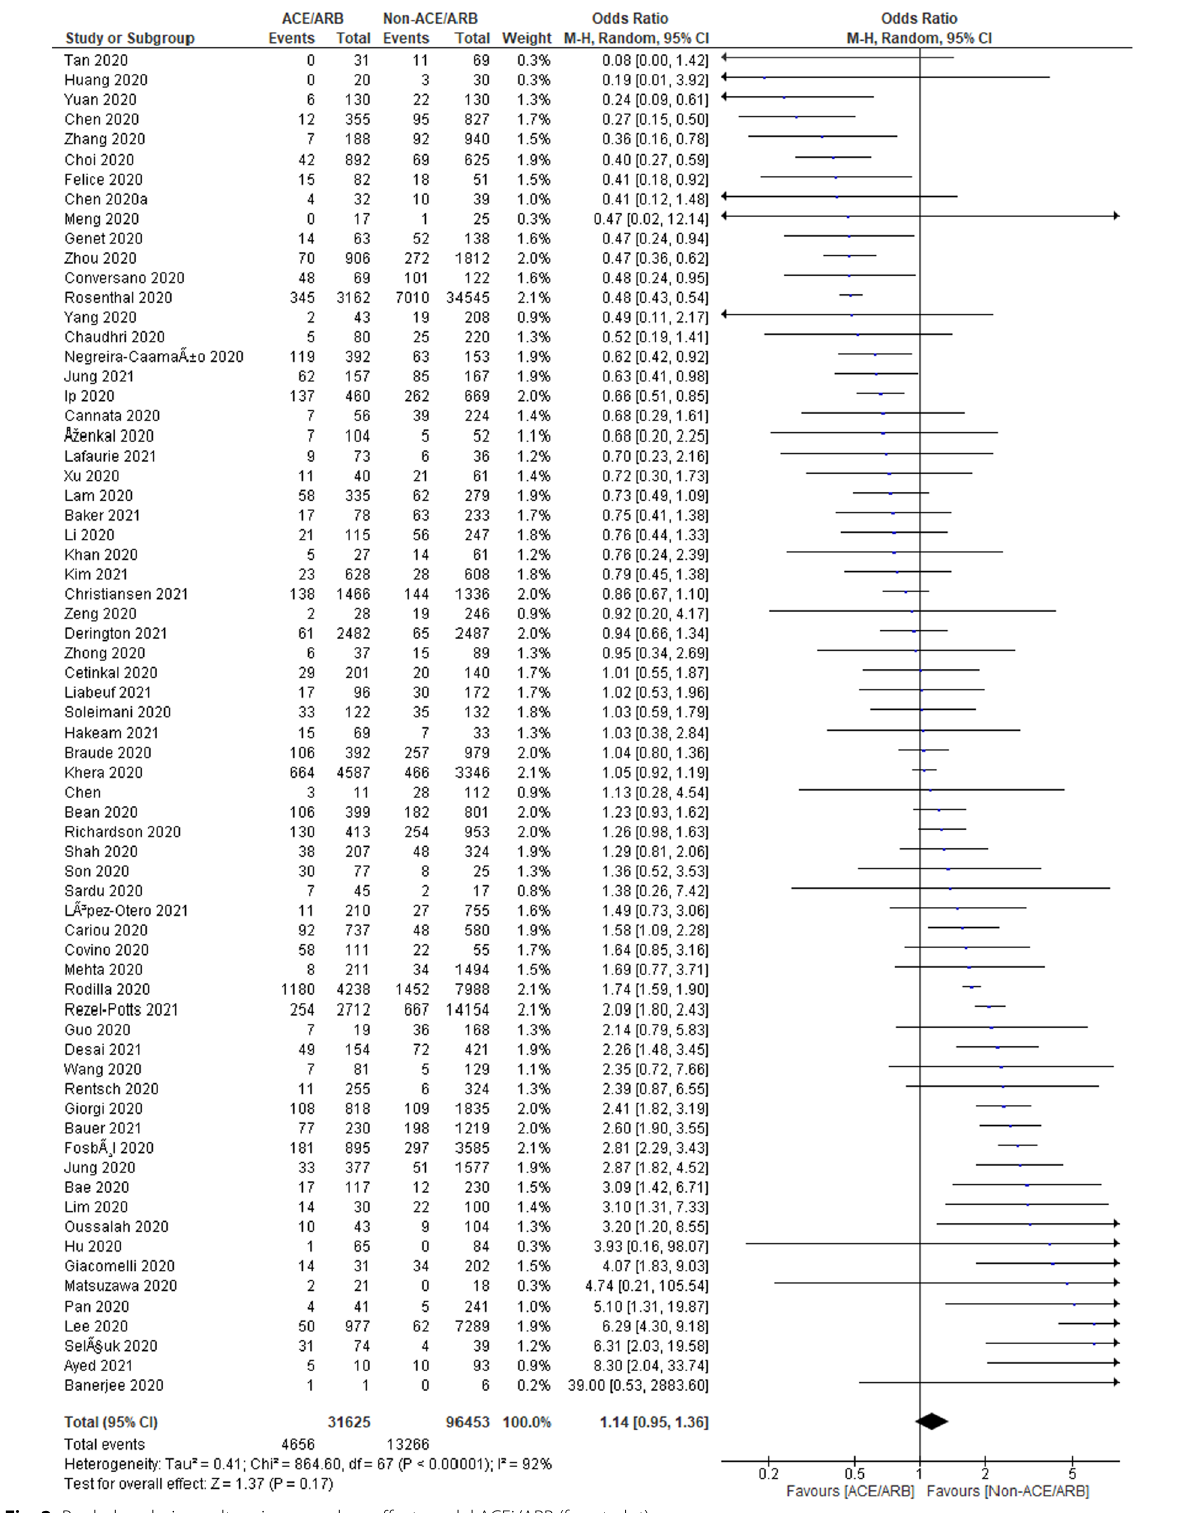
Fig. 2 Pooled analysis results using a random effect model ACEi/ARB (forest